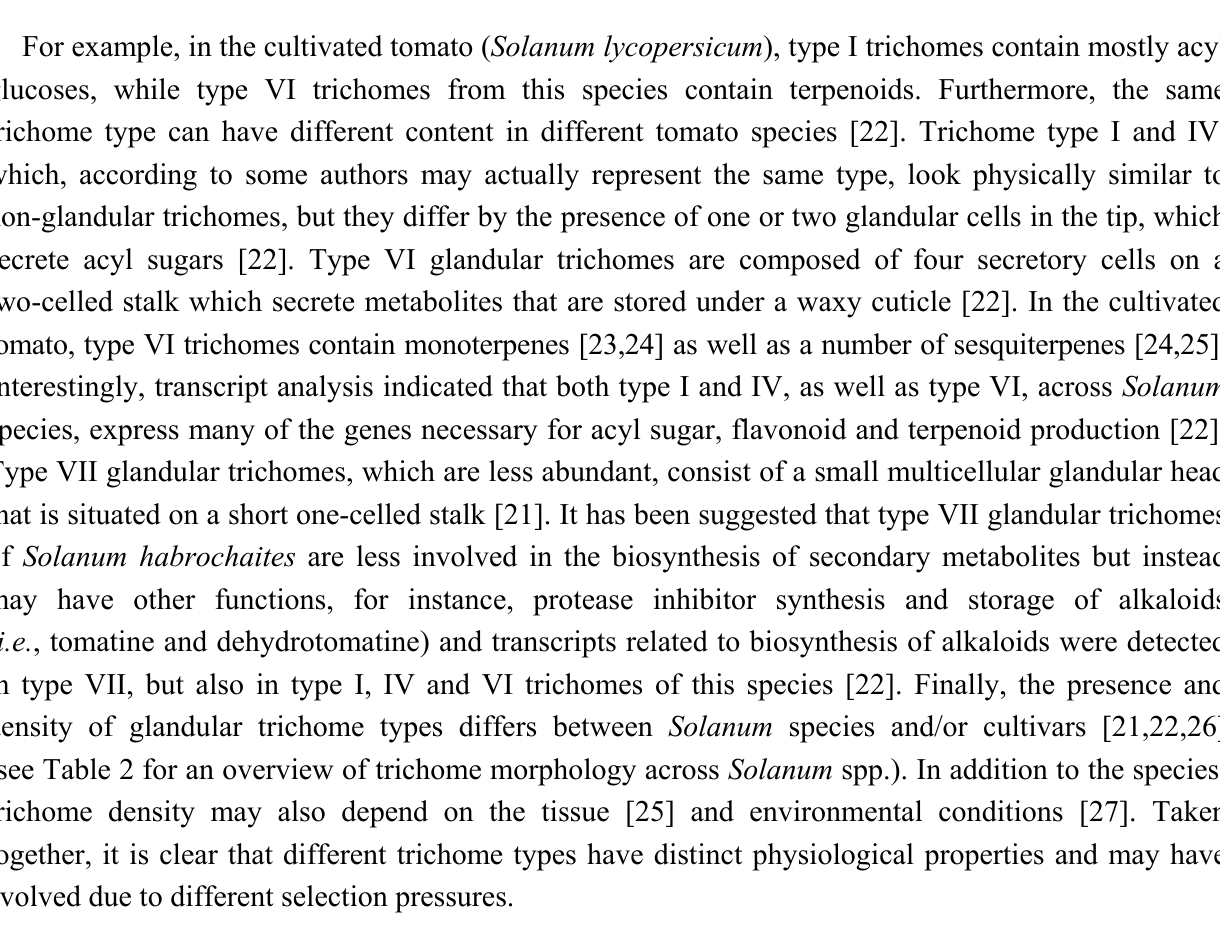
Table 2. Distribution of trichome types in the section Lycopersicon of the genus Solanum .